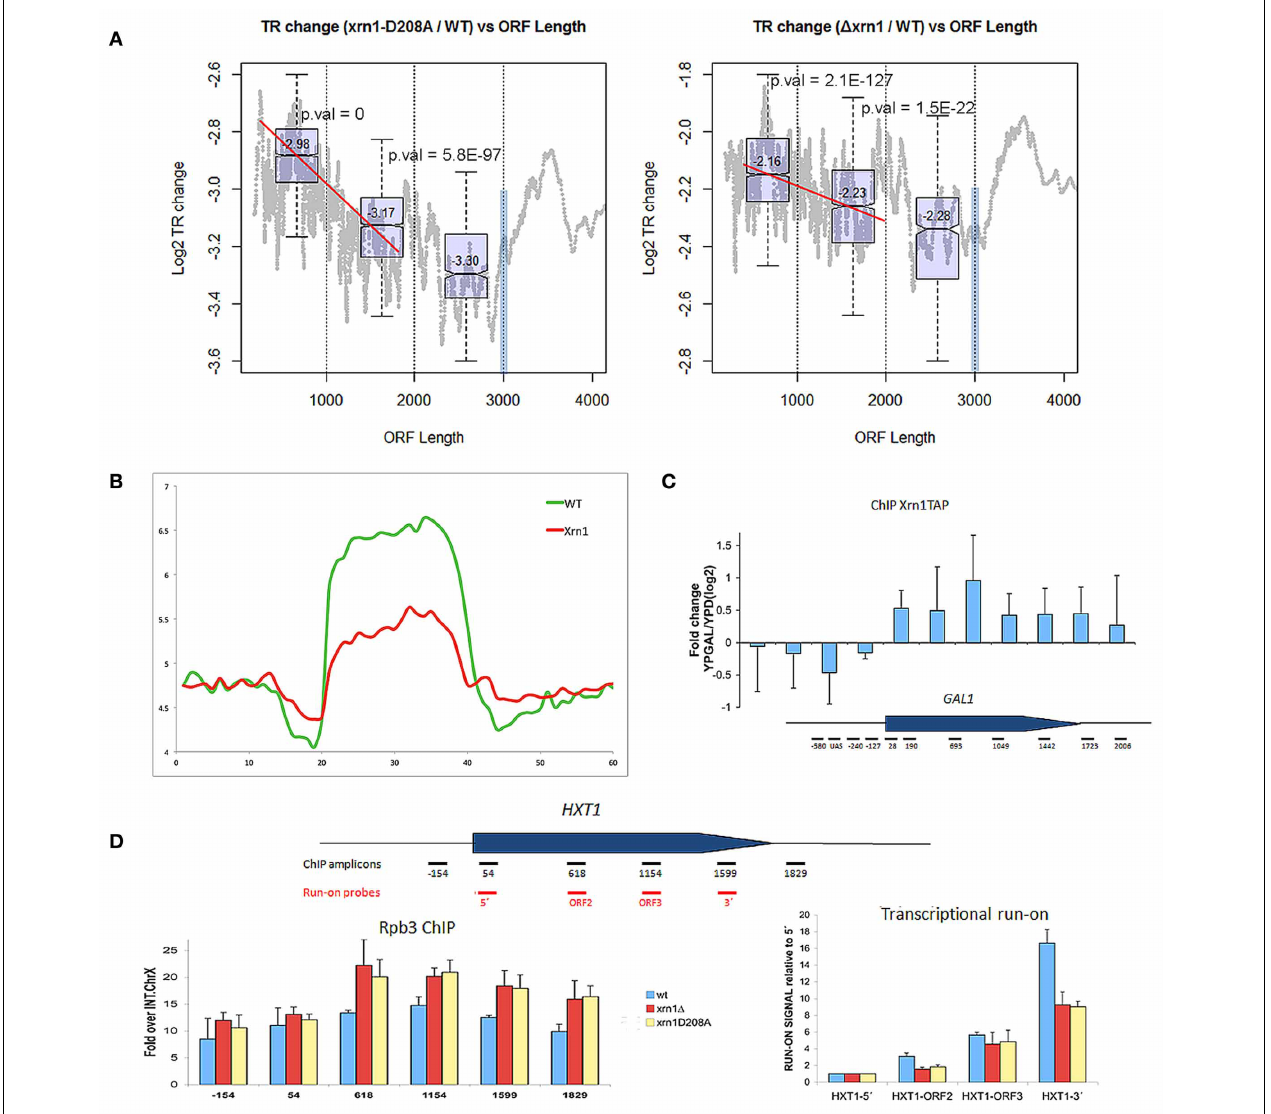
FIGURE 6 | nTR decreases in xrn1 mutants. (A) Changes in nTR of the xrn1 mutants are plotted against ORF length. A decreasing tendency is clearly seen for the genes between 300 and 2000bp. This is result is reinforced with the box-plots (distribution and median values and p -values for the difference between two consecutive groups) for the genes situated in each of the three groups of the distribution (0-1kb, 1-2kb, 2-3kb). At 3kb, a blue bar shows the artifact caused by the displacement toward 3 (cid:2) during the run-on, which provokes a bias against long genes (see Pelechano et al., 2010). However, the ratio between xrn1 and wt should not be affected. This challenges the interpretation of the graphs, although it indicates that the behavior of the final 1kb differs from the rest. (B) Presence of active RNA pol II along a “metagene” at a high resolution using BioGRO average for the whole yeast genome. On the Y-axis, the arbitrary fluorescence value indicates elongating